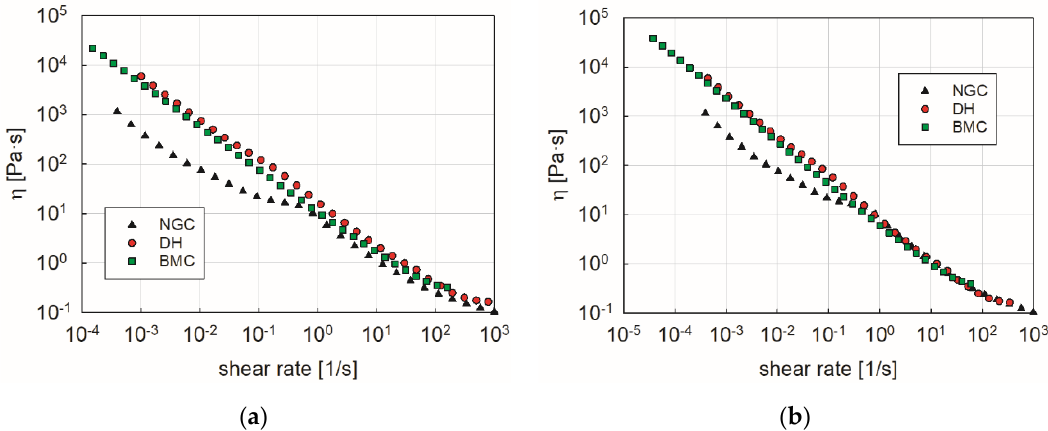
Figure 8. The viscosity of the OBM drilling fluid suspension as a function of shear rate for the NGC and the two complex geometries. ( a ) Results obtained by using the c SS and c SR coefficients provided by Anton Paar; ( b ) Results obtained by using the c SS and c SR coefficients from the Couette analogy.